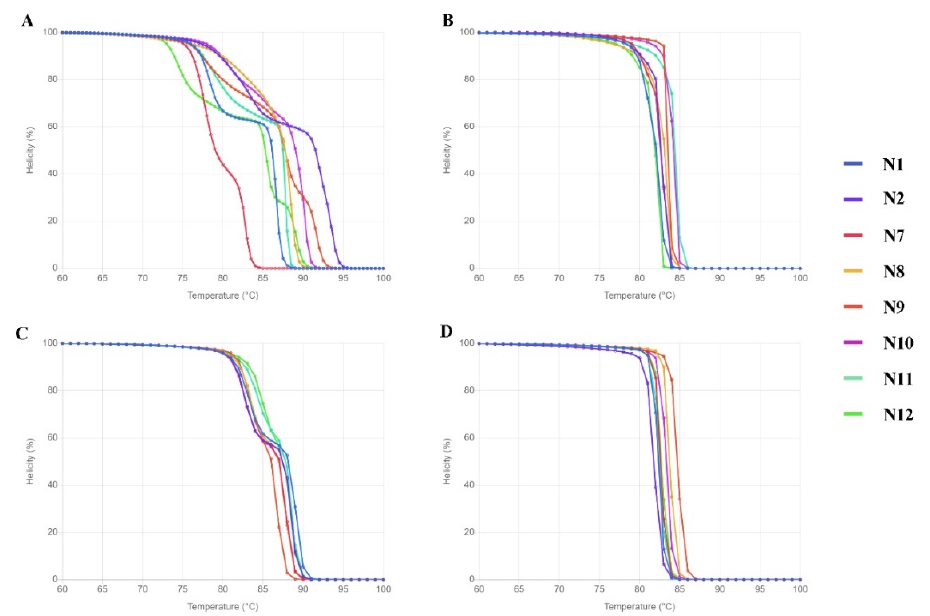
Figure 2. Melting curve prediction from uMELT Quartz based on DNA sequences from the four selected regions. ( A ) ITS, ( B ) mat K, ( C ) rbc L, and ( D ) trn L.